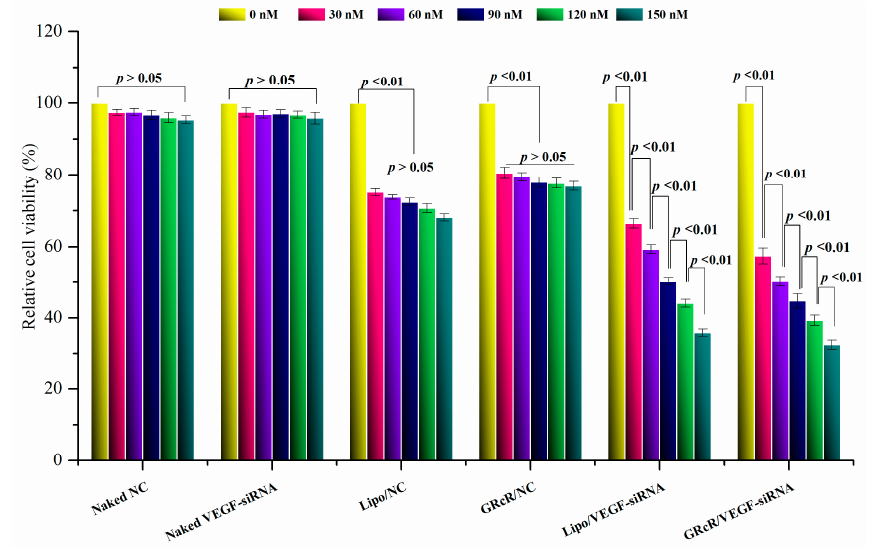
Figure 12. HeLa cell viability treated with NC, VEGF-siRNA , Lipo™2000/NC, GRcR/NC, Lipo™2000/ VEGF-siRNA , and GRcR/ VEGF-siRNA . The data is presented as the mean ± SD, n = 3.